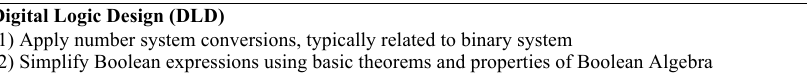
Table 2. The developed set of course learning outcomes (CLOs) per course; only CLOs with a high-emphasis (H) mapping to the PIs are